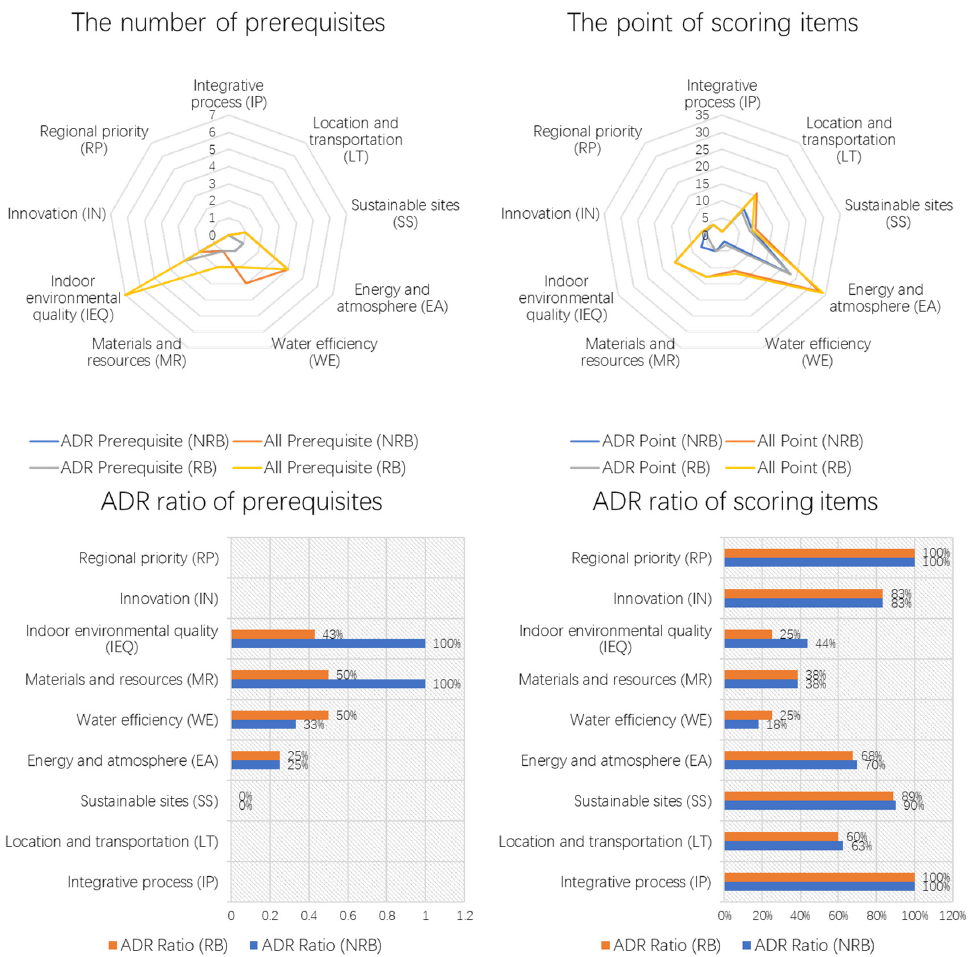
Figure A1. Breakdown of the number of prerequisites, the point of scoring items, and ADR ratios in diverse categories of LEED. (Source: by the author).